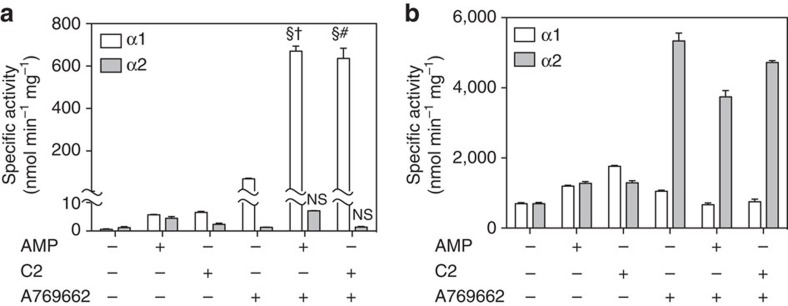
C2/A769662 synergistic activation of AMPK.Wild-type AMPK α1 and α2 were pre-treated with (a) λ-phosphatase or (b) CaMKK2, and assayed in the absence/presence of AMP (100 μM) and C2 (0.1 μM), either individually or in combination with A769662 (20 μM). Results from triplicate experiments are presented as mean specific activity (nmol min−1 mg−1±s.e.m.), with statistical tests conducted using one-way ANOVA Sidak's multiple comparisons test. Symbols §, † and #; P<0.01 indicate significant increase in activity compared with A769662, C2 and AMP controls, respectively, while NS indicates that there was no significant difference between the co-incubated samples and their individual control samples.